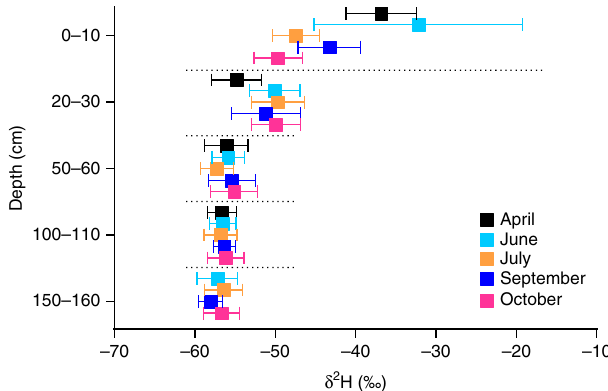
Fig. 2 Seasonal fl uctuations of δ 2 H values in peat pore water in 2015. For each depth at a sampling time, fi ve repeat water samples were collected. Error bars represent 1 s.d. of the batch samples ( n =